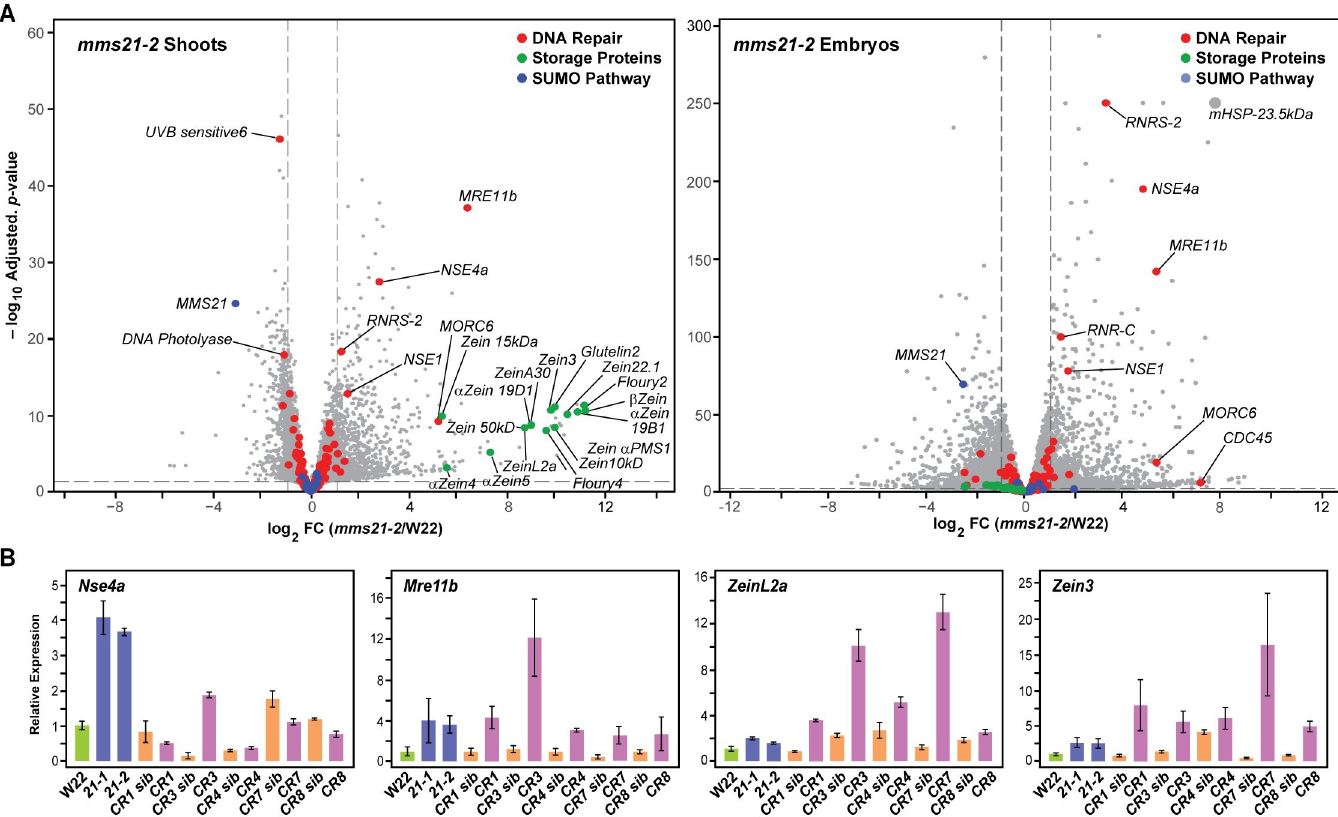
Fig 6. MMS21 Strongly Influences the Expression of a Subset of the Maize Transcriptome. (A) Volcano plot representation of DEGs in the mms21-2 shoots and embryos as compared to those in W22 based on log 2 FC and -log 10 adjusted p -values. Blue, red, and green dots identify genes involved in the SUMO pathway and DNA repair, or encode seed storage proteins, respectively. Specific DEGs of interest are noted. (B) Confirmation of select DEGs shown in panel (A) by qRT-PCR analysis of the collection of mms21 mutants generated by UniformMu or CRISPR/Cas9-mediated mutagenesis (see Fig 1). The results from the CRISPR/Cas9 mutants were compared to their normal siblings. Each bar represents the mean of three biological replicates ( ± SD). See S7 Fig for similar volcano plots analyzing the transcriptomes of mms21-1 shoots, mms21-1 embryos and endosperms for both